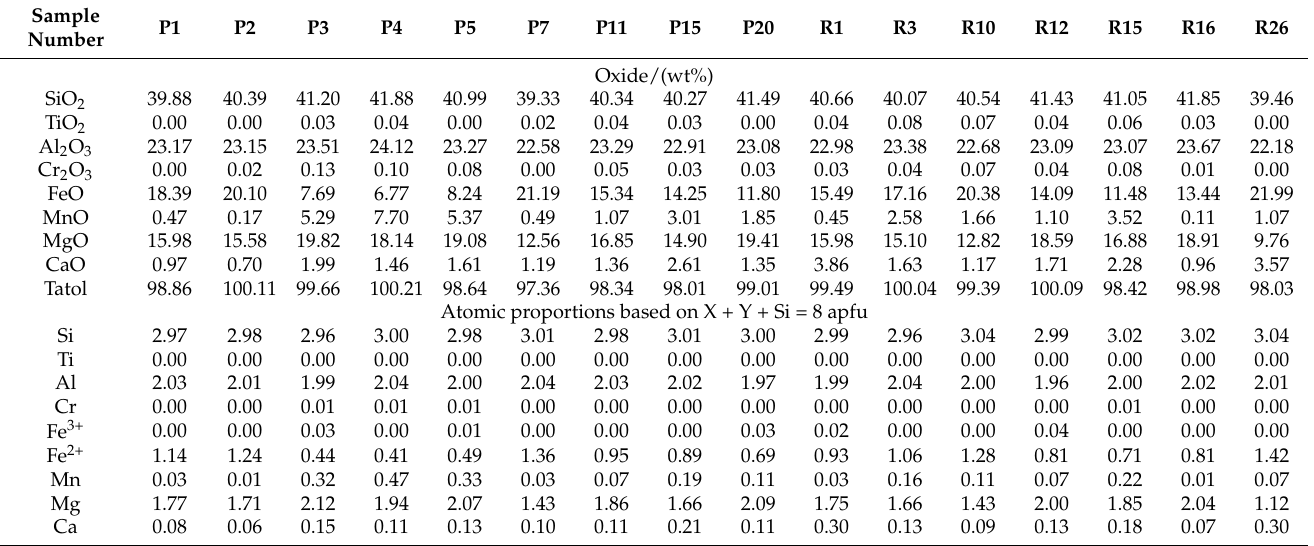
Table 2. Representative chemical compositions of red-purple pyrope-almandine tested by electron microprobe (wt%).